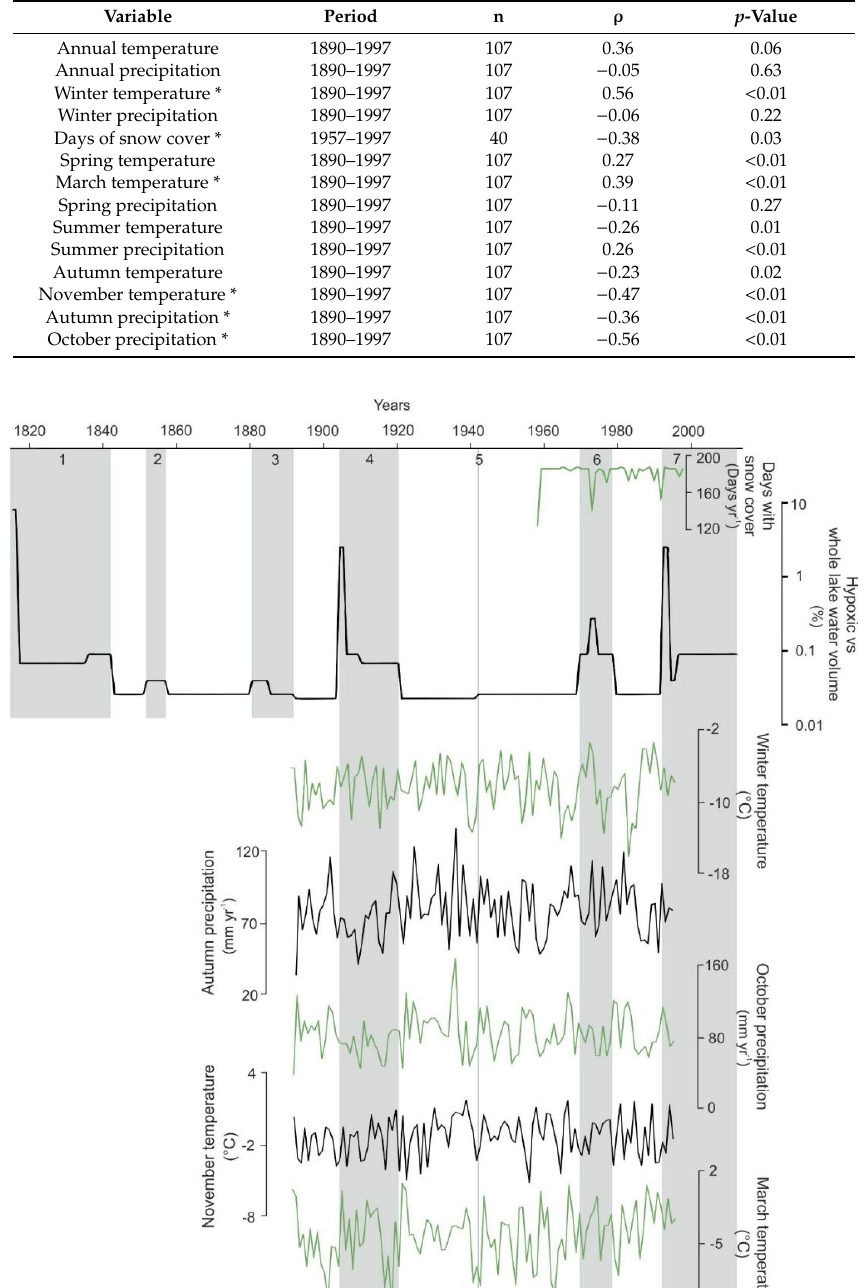
Table 4. Correlation between hypoxia volume and studied climate variables. From the monthly spring and autumn temperature and precipitation variables, only those with statistically significant correlations ( p -value < 0.05) are shown. Time periods of available monitoring data, number of data points (n), correlation coe ffi cients ( ρ ), and p -values are provided. * Variables with correlation coe ffi cients > 0.3 and p -values < 0.05.